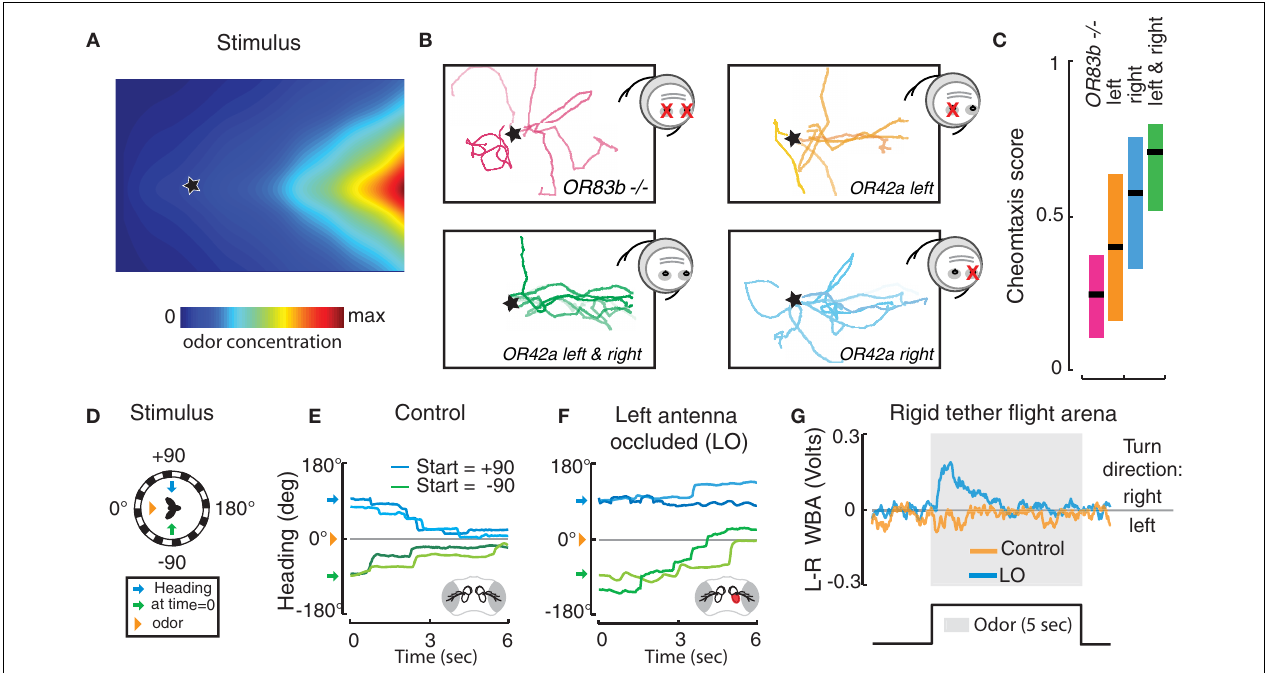
FIGURE 3 | Behavioral performances of Drosophila with unilateral olfactory function. (A–C) Drosophila larvae do not require bilateral sensory input for chemotaxis. (A) Topographic reconstruction of a controlled exponential odor gradient based on infrared spectroscopy (for details see Louis et al., 2008a). The star represents the location in the arena where the larva is introduced. (B) Representative experimental trajectories of OR83b null mutants (red) and larvae with olfactory input rescued bilaterally (green) or unilaterally in a single functional OR42a -expressing ORN (left, orange; right, blue). (C) Quantifi cation of chemotactic performance with a score measuring the overall alignment of the trajectory with the gradient (data of panels A–C are adapted from Louis et al., 2008a). (D–G) Adult fl ies use bilateral